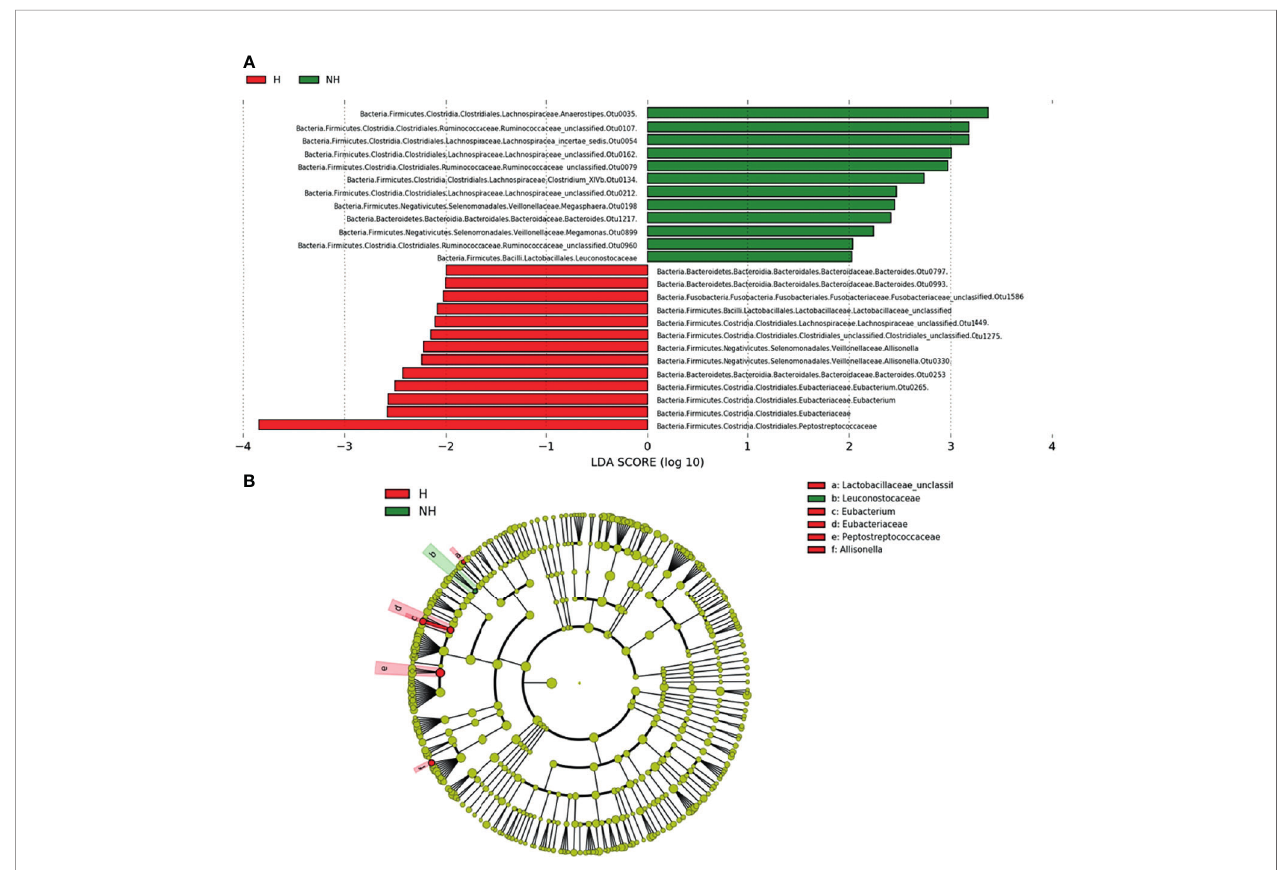
FIGURE 4 | LDA score (A) and evolutionary diagram (B) , with circles representing taxonomic levels from phylum to genus/species. Each small circle at a different classi fi cation level represents a classi fi cation at that level, and the diameter of the small circle is proportional to the relative abundance. The species with no signi fi cant difference were yellow, while the differential species were colored as